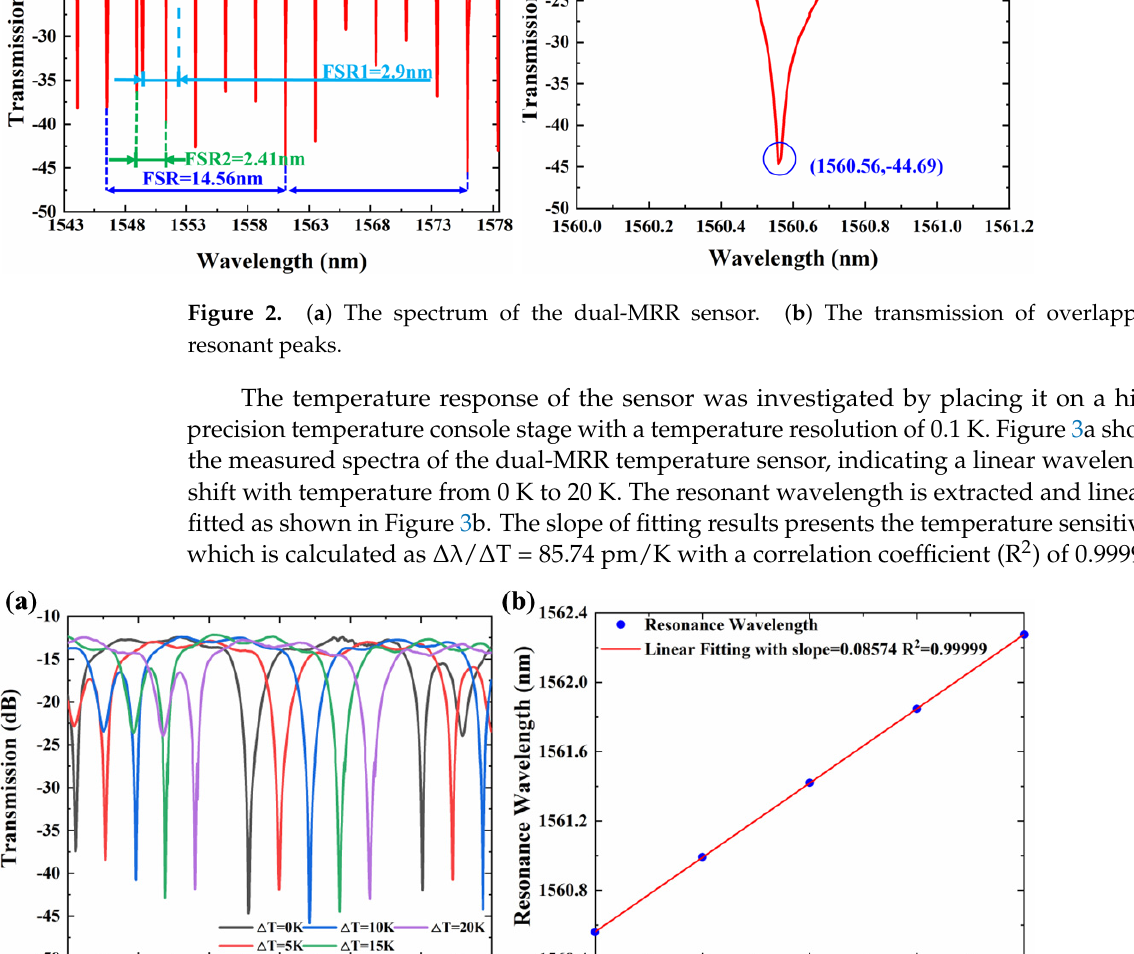
Figure 3. ( a ) Spectra of the dual-MRR sensor at different temperatures (ranging from 0 K to 20 K). ( b ) Overlapping resonant peak wavelength at different temperatures.